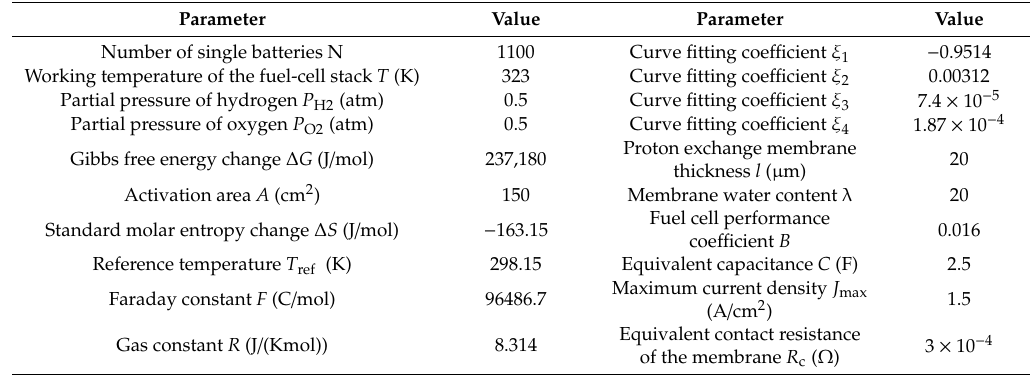
BSOC Figure 5. Relationship between open-circuit voltage and battery state of charge (BSOC) [20].